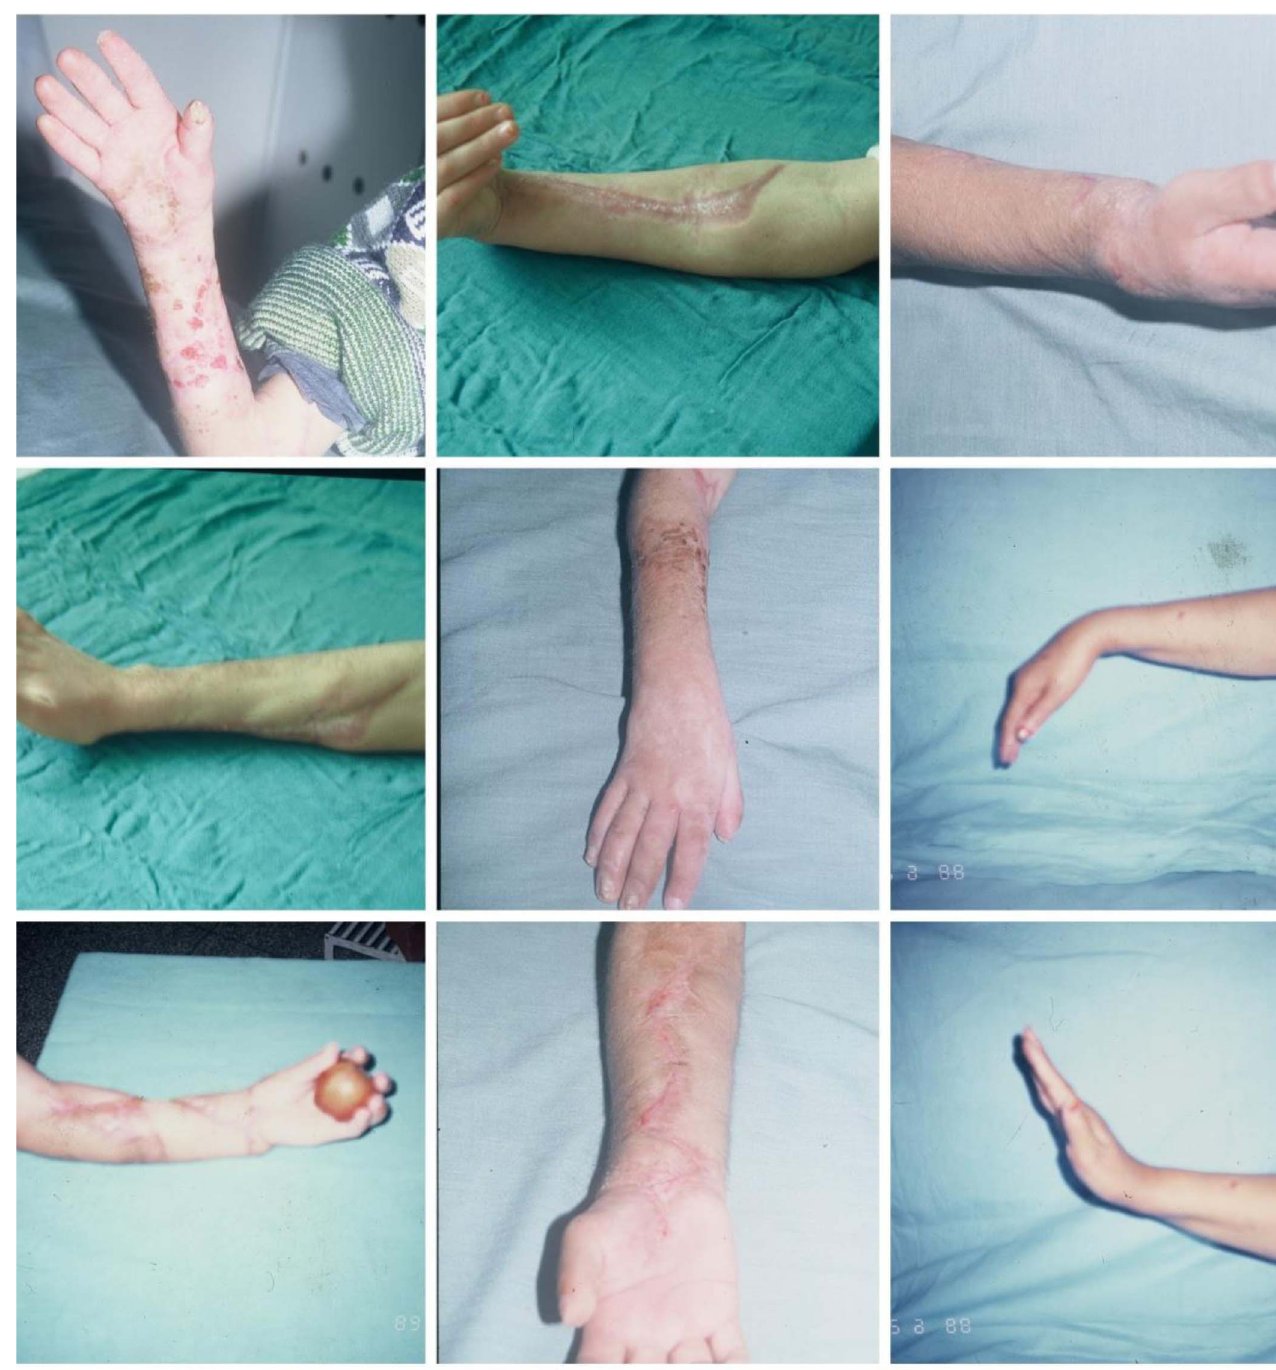
Figure 8. Results of various cases operated with different surgical procedures:slide procedure, fasciotomy, osteotomy, transplantation; the goal of surgery is to maximize limb